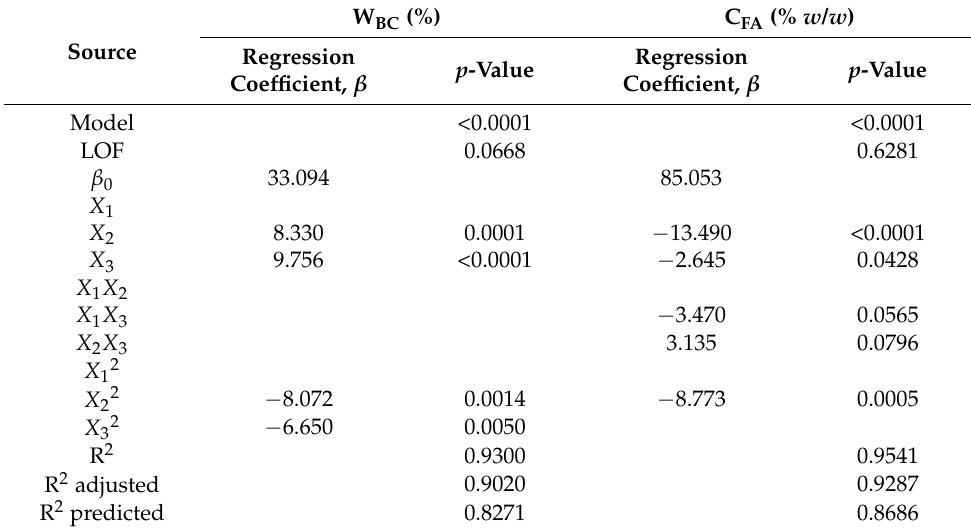
Table 6. Regression coefficients of the reduced mathematical models with their statistical significance and model parameters for black cumin seed extraction yield (W BC ) and fatty acid content (C FA